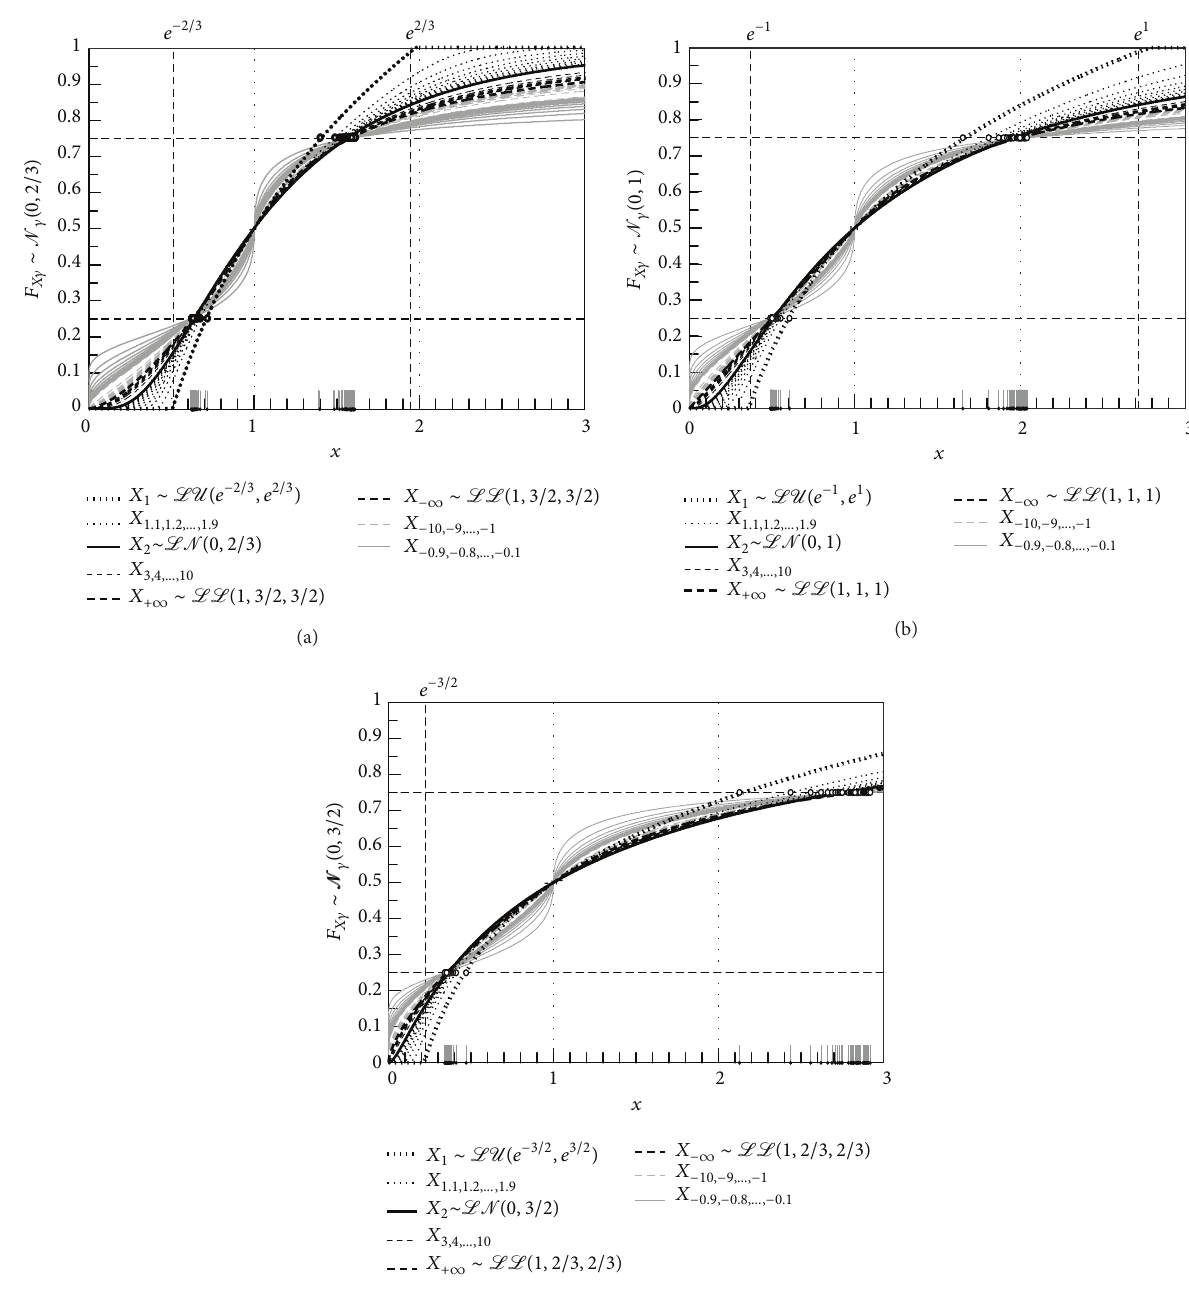
Figure 2: Graphs of the c.d.f. 𝐹 𝑋